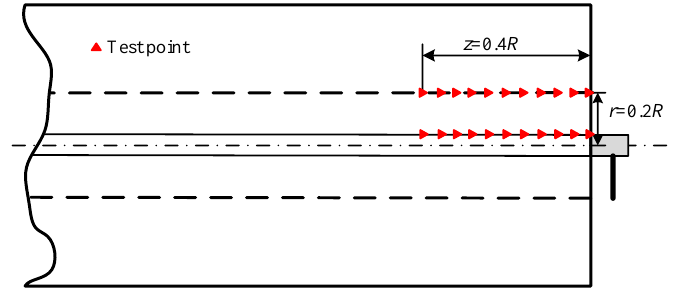
Figure 13. Location of the test points in the vertical direction.